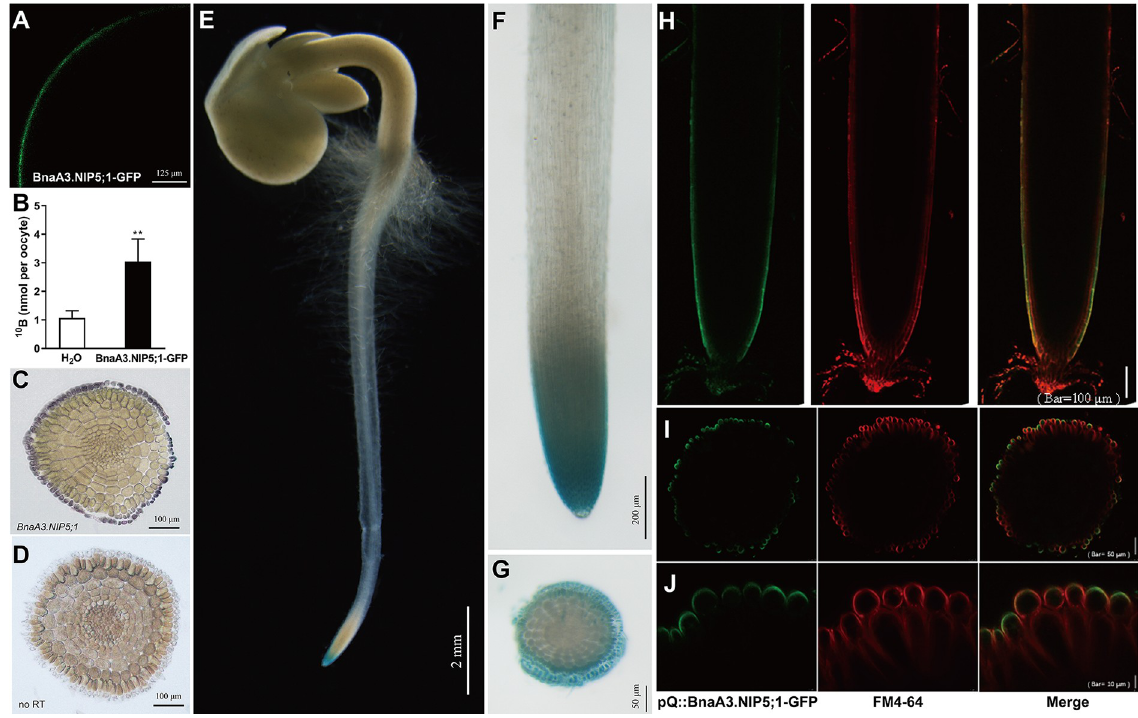
Fig 2. Functional characterization and tissue and subcellular localization of BnaA3.NIP5;1. ( A ) Subcellular localization of BnaA3. NIP5;1-GFP within the oocyte membrane. ( B ) Boric acid uptake in Xenopus oocytes injected with BnaA3.NIP5;1-GFP composed of 10 B. The data presented are mean values with s.d. of four replicates. �� P < 0.01 (Student’s t -test). ( C and D ) RNA in situ RT-PCR of the cell-specific expression pattern of BnaA3 . NIP5;1 in root tip cross-sections. The dark blue signal indicated the presence of BnaA3 . NIP5;1 mRNA; no reverse transcription (no RT) conditions were used as negative controls. Similar results were observed in each of three independent experiments. ( E-G ) GUS staining of roots and cross-sections of root tips of pQ::BnaA3.NIP5;1-GUS transgenic plants. Similar results were observed in each of the three independent transgenic lines. ( H-J ) Confocal images of pQ::BnaA3.NIP5;1-GFP transgenic plants with vertical sections and cross-sections of the root tips; FM4-64 was used as a membrane-selective tracer. Similar results were observed in each of the three independent transgenic lines. All the rapeseed plants analysed were grown in solid media consisting of 0.1 μ M B. Scale bars as shown.